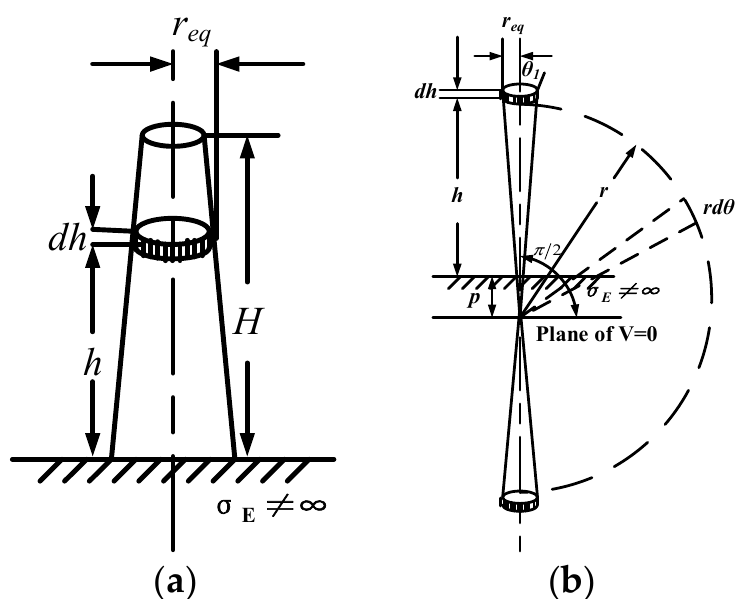
Figure 4. Conical antenna model of vertical conductor infinitesimal element. (a) The infinitesimal element of the vertical conductor; (b) The Conical antenna model.